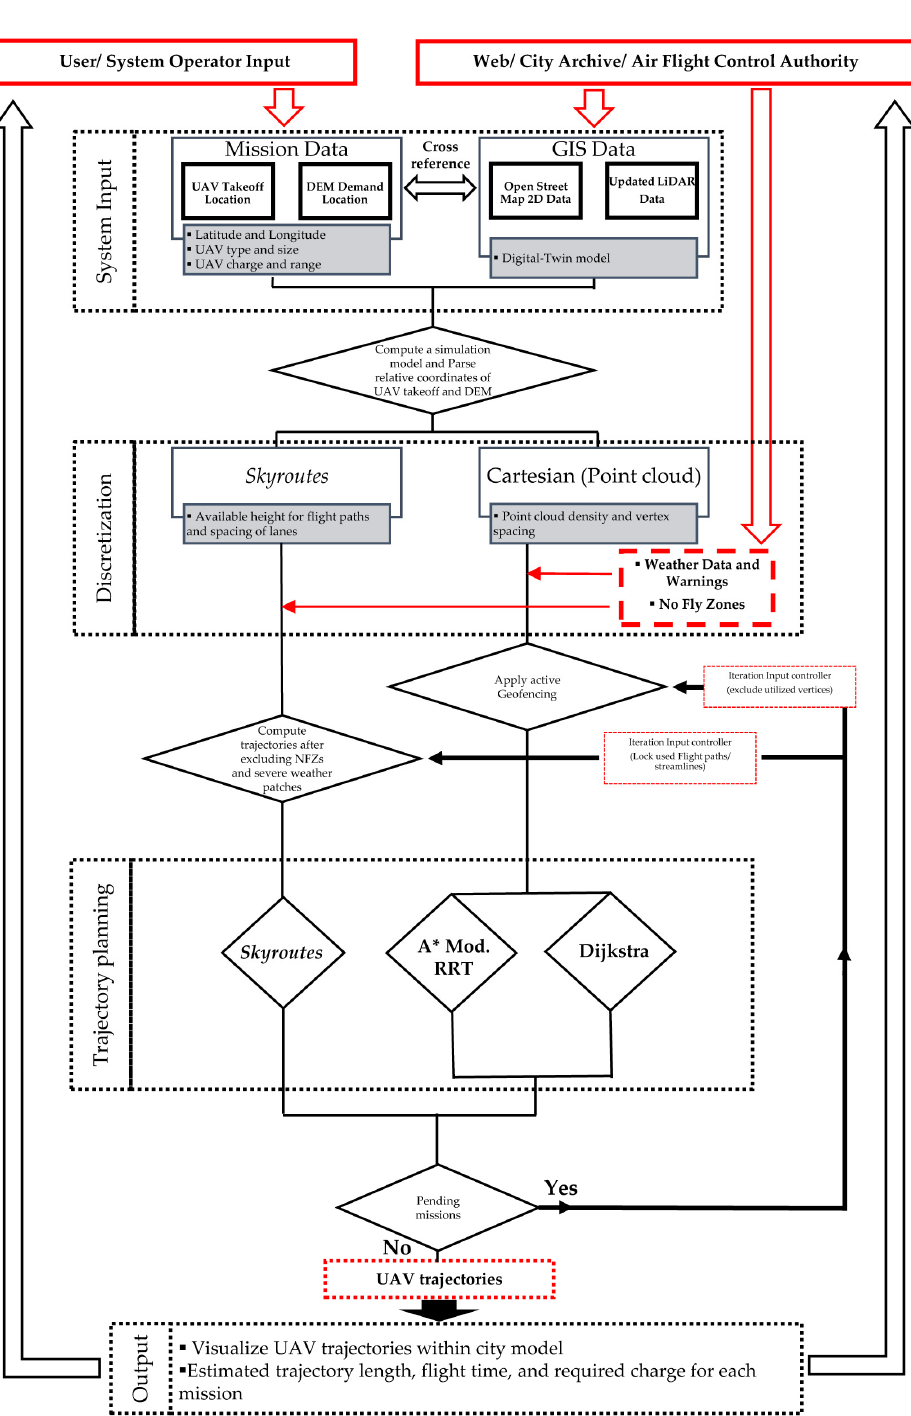
Figure 7. Autonomous UAV simulation framework illustration.